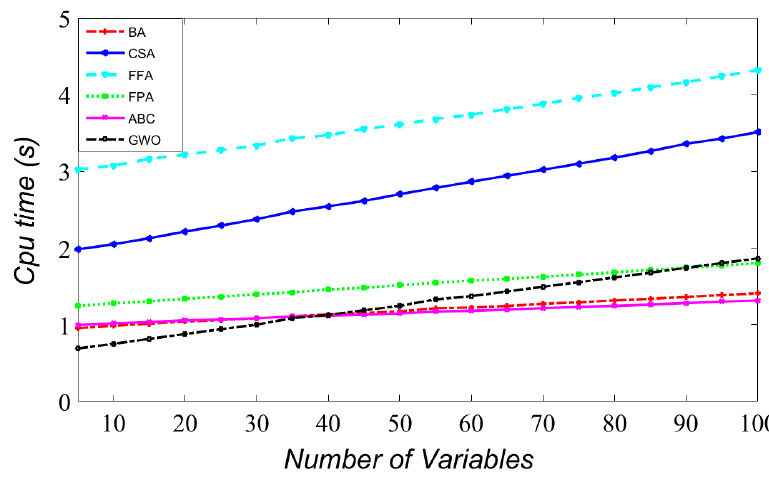
Figure 6. Impact of increasing number of function dimensions vs. CPU time for Sphere function.